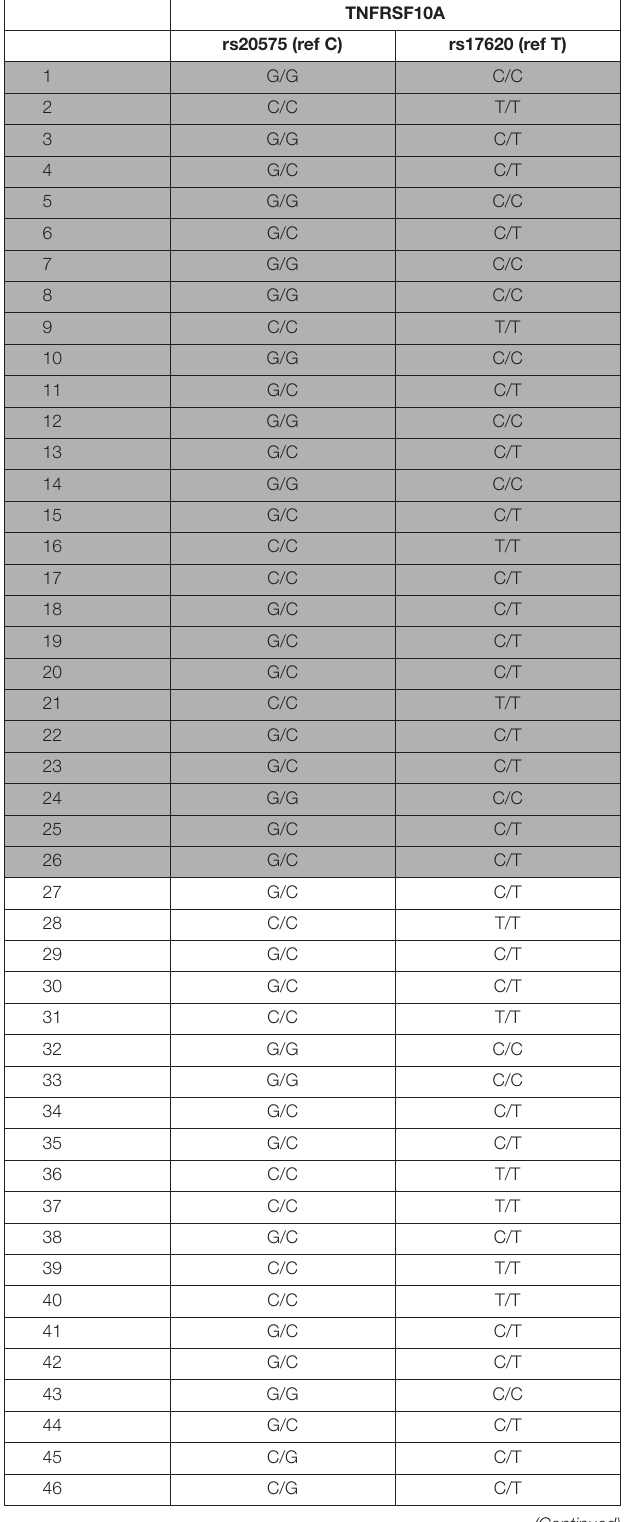
TABLE 2 | SNPs analysis results in all patients cohorts.